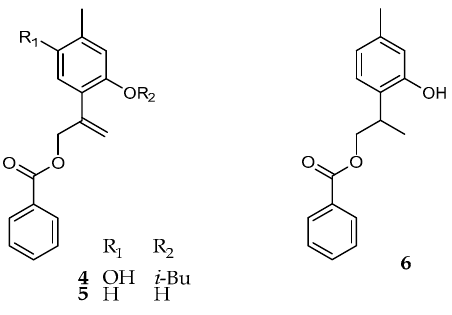
Figure 3. Chemical structures of 4 – 6 .